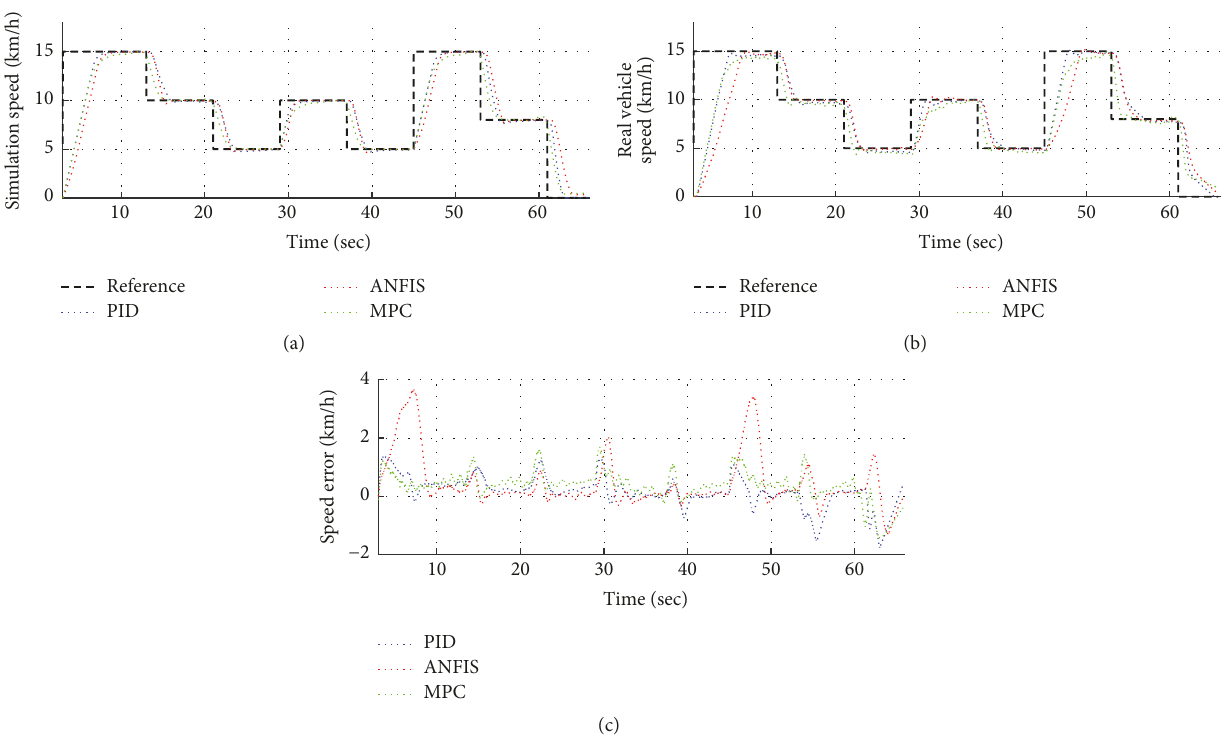
Figure 9: Speed response in simulation and real